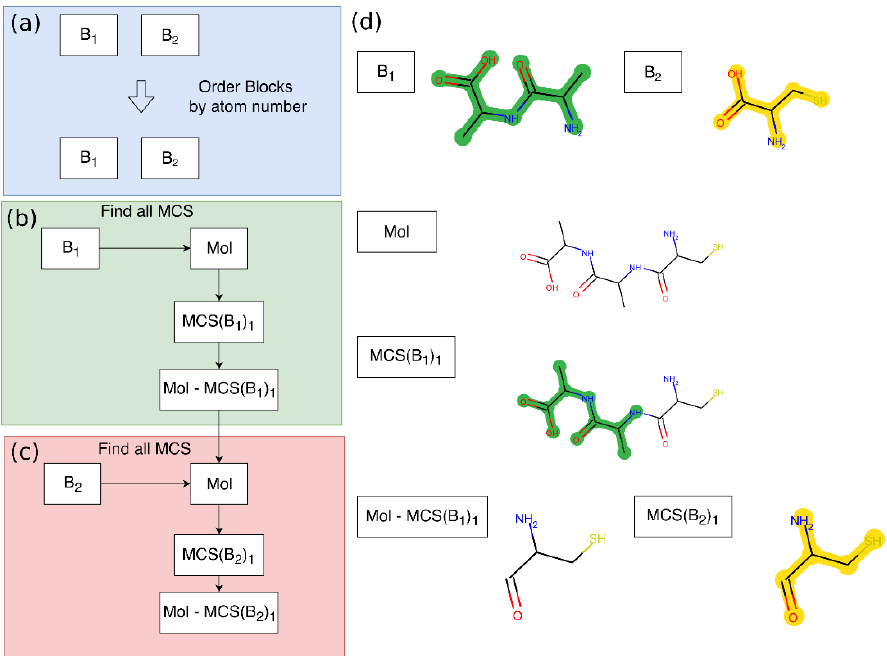
Figure 9. Example demonstration of the extended MCS algorithm. To simplify the example, only two building blocks are used; the algorithm can potentially scale up to 10 building blocks. ( a ) Initially, the building blocks are ordered by their number of atoms. The matches of the biggest building blocks are most meaningful. ( b ) All MCSs of the first block (B1) with the target molecule (Mol) are computed. The example shows only one MCS, but some molecules (especially ring systems) can have large numbers of MCS. The number of MCS to find for each B1 in a target molecule (Mol) is limited to 20. ( c ) A new molecule is created for each MCS, where the MCS is removed from the scaffold. This new molecule is then submitted to a new MCS search with the next building block (B2). ( d ) A visual example of the scoring algorithm based on two predicted scaffold fragments. First, the dipeptide (B1) is scored; then, the second molecule (B2) is scored on the remaining part of the target molecule